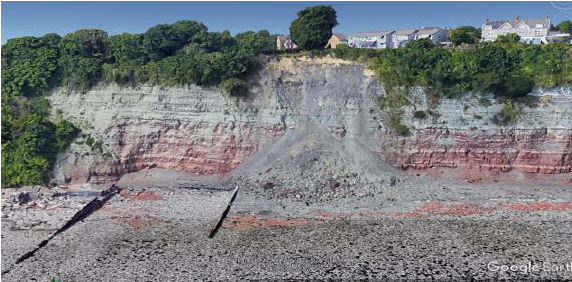
Figure 19. 2018 Google Earth Imagery of the Study